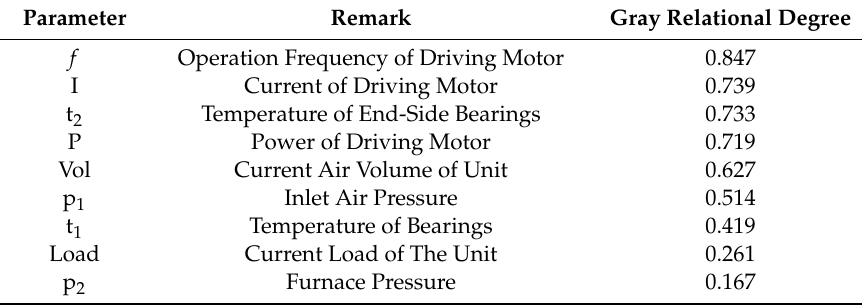
Table 3. Results of grey relational analysis for vertical